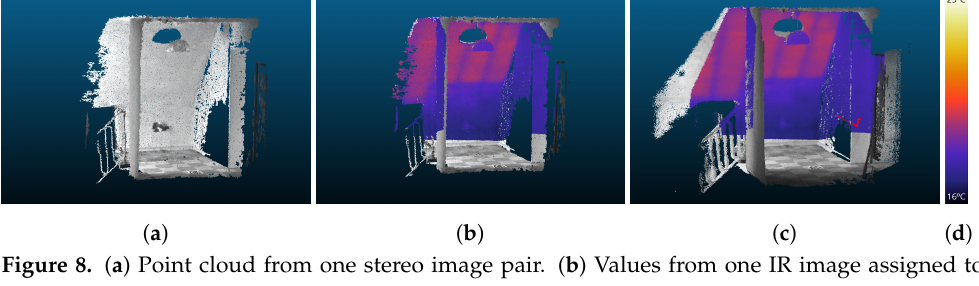
Figure 8. ( a ) Point cloud from one stereo image pair. ( b ) Values from one IR image assigned to the point cloud from one stereo pair recorded at the same time. ( c ) Values from one IR image are assigned to a point cloud accumulated from multiple images that have been recorded from the red dotted positions. Some parts (e.g., behind the ceiling lamp) are hidden in the IR camera view and are, therefore, excluded from IR mapping; ( d ) color bar with temperature values.